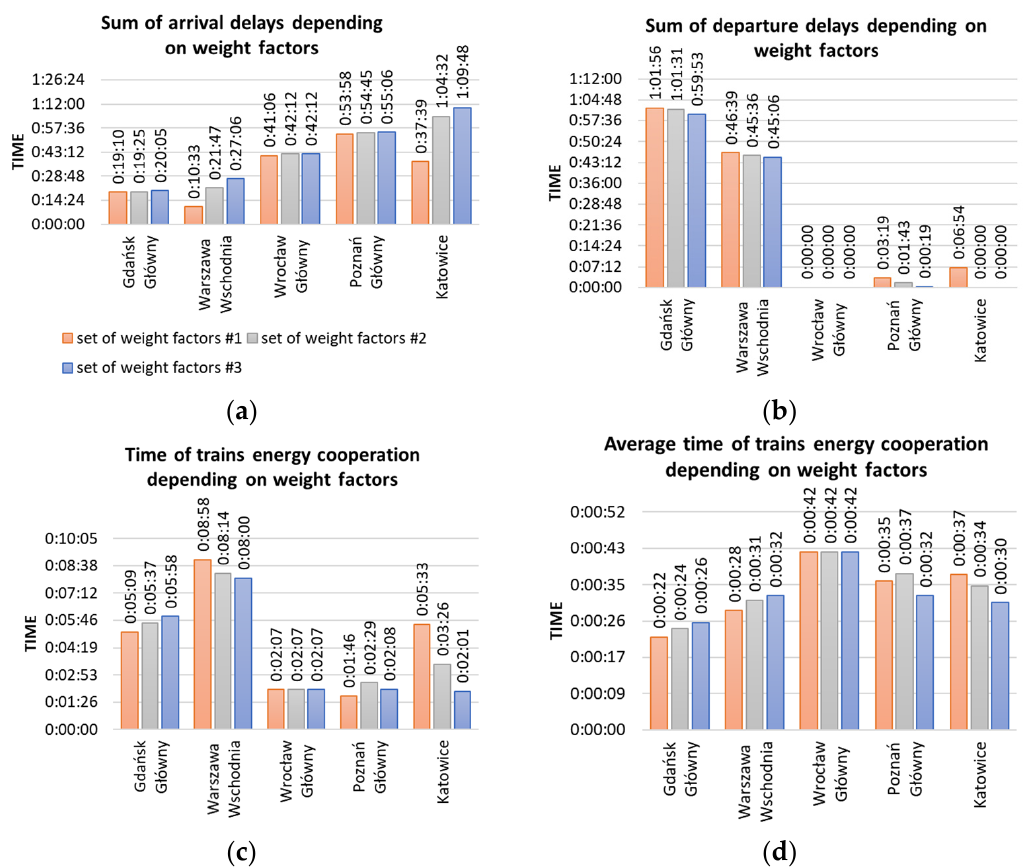
Figure 6. Summary of the results of the individual component functions of multi-criteria optimiza- tion (24) according to the adopted weight factors 1–3. ( a ) Sum of arrival delays depending on weight factors. ( b ) Sum of departure delays depending on weight factors. ( c ) Time of trains energy cooper- ation depending on weight factors. ( d ) Average time of trains energy cooperation depending on weight factors. Source: own study.